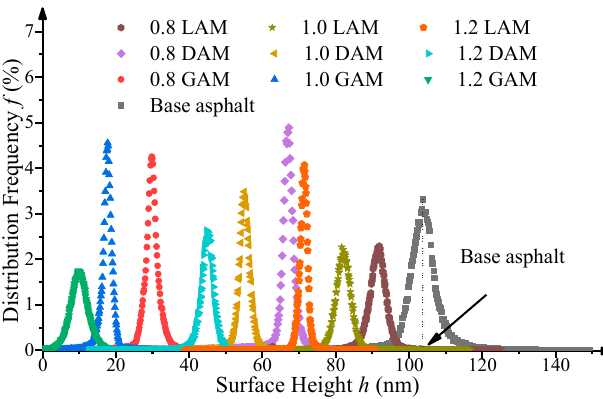
Figure 10. Distribution frequency of the surface height.